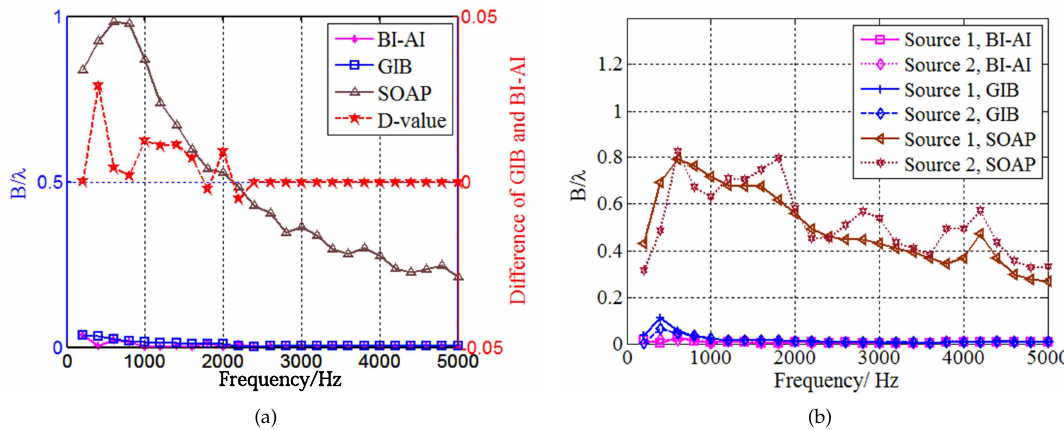
Figure 6. The − 12 dB beam width varying radiation frequency: ( a ) one unitary monopole sound source; ( b ) two coherent monopole sound sources, the strength of source one and source one is 1 and 0.5,